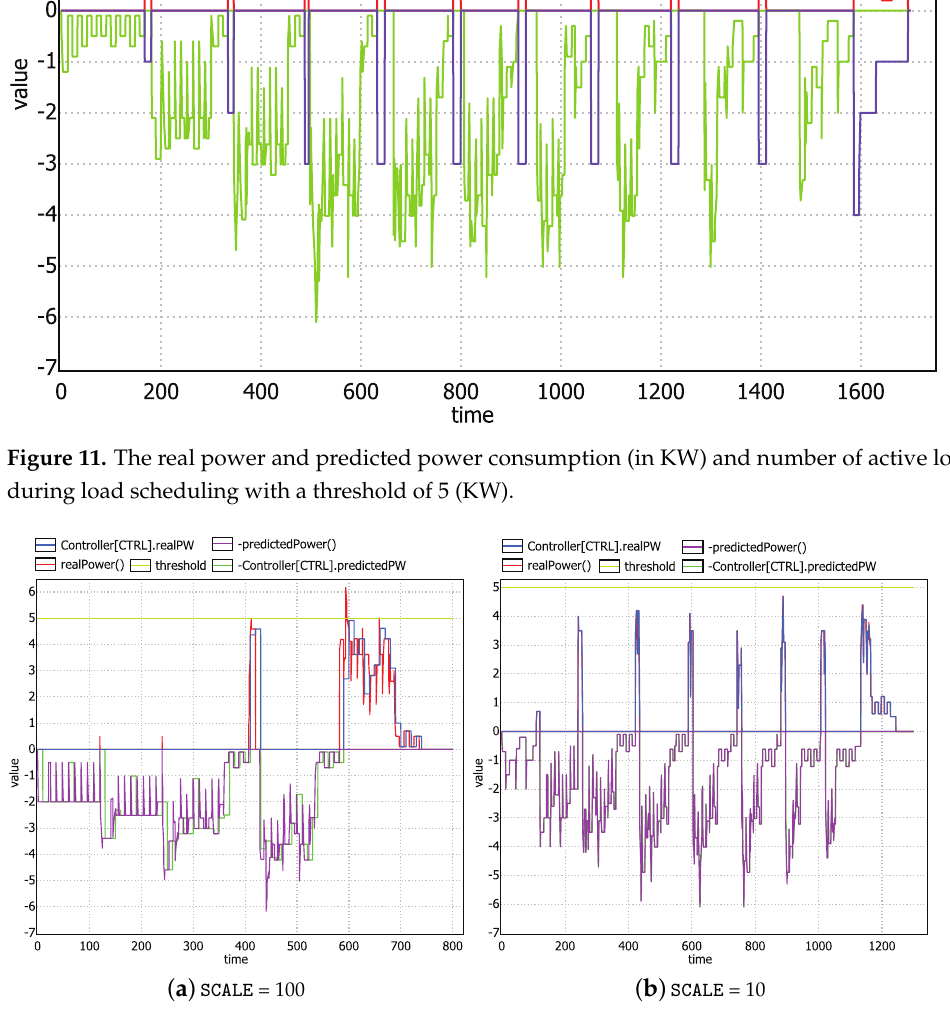
Figure 12. The consumption curve (in KW) of the considered appliances vs. time in the case two different SCALE factors are